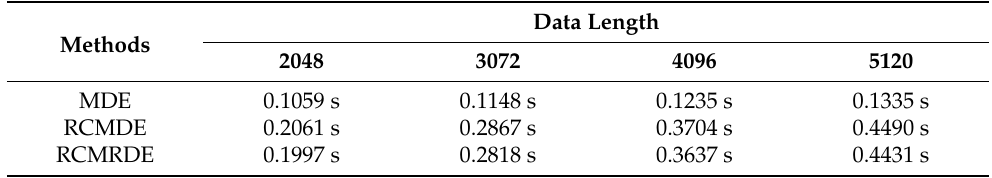
Table 1. The comparison of computation time of three entropy values under different data